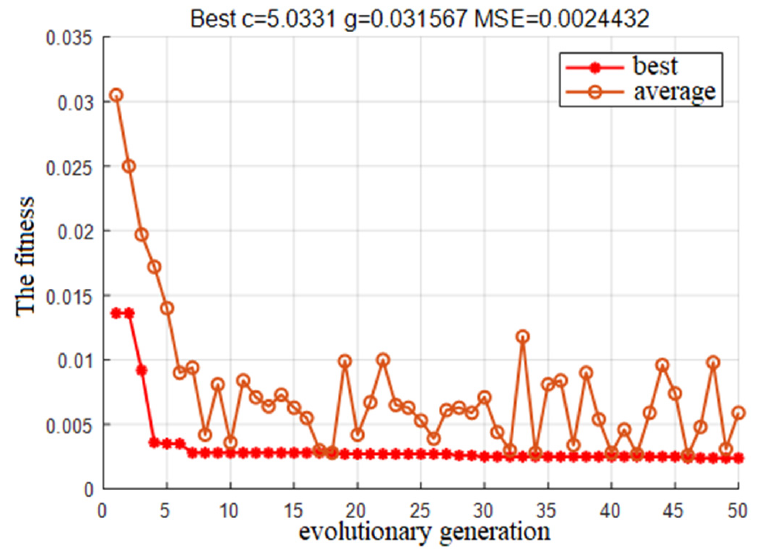
Figure 11. Grid-SVM test set data fit.